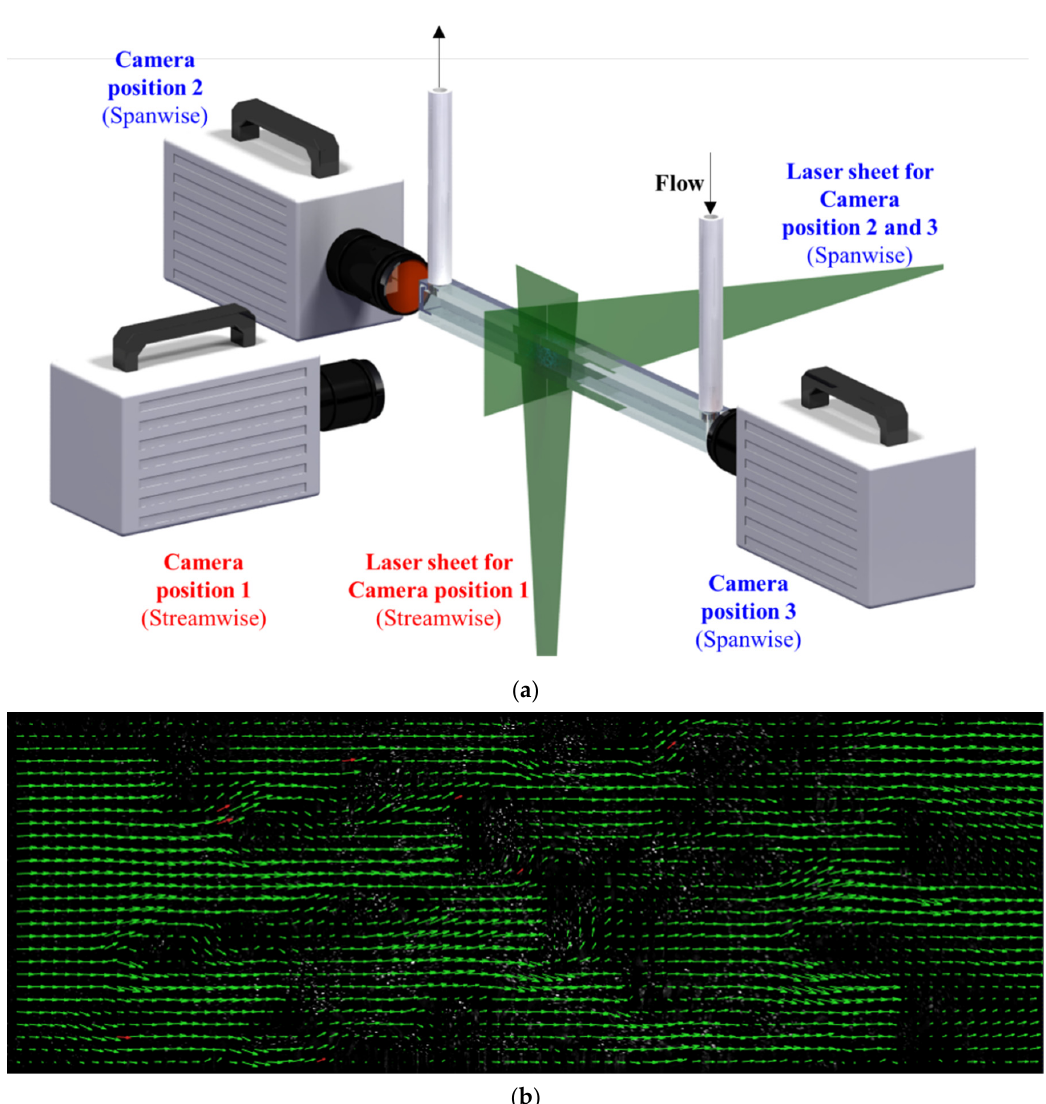
Figure 5. ( a ) PIV measurement setup; ( b ) instantaneous velocity vectors (stream-wise—position 1).